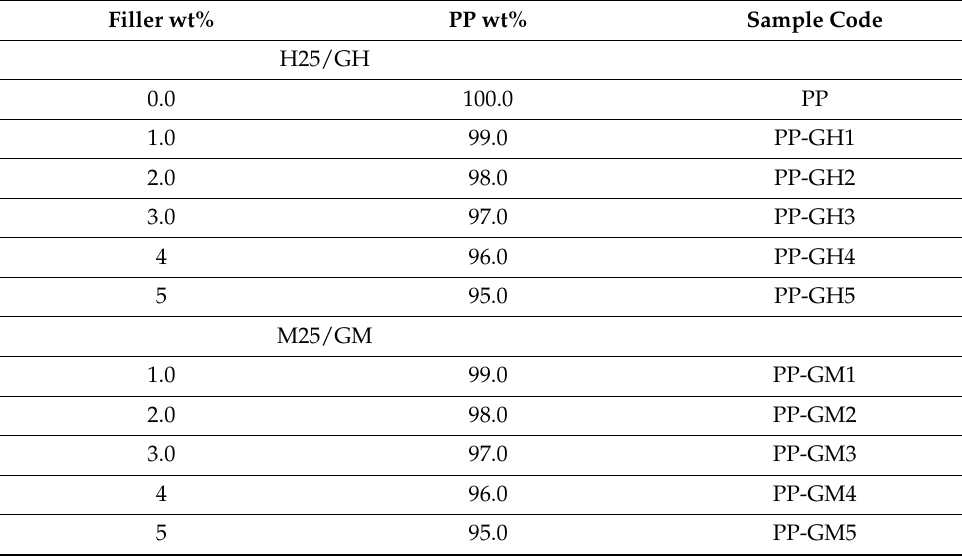
Table 2. Prepared composites and corresponding sample